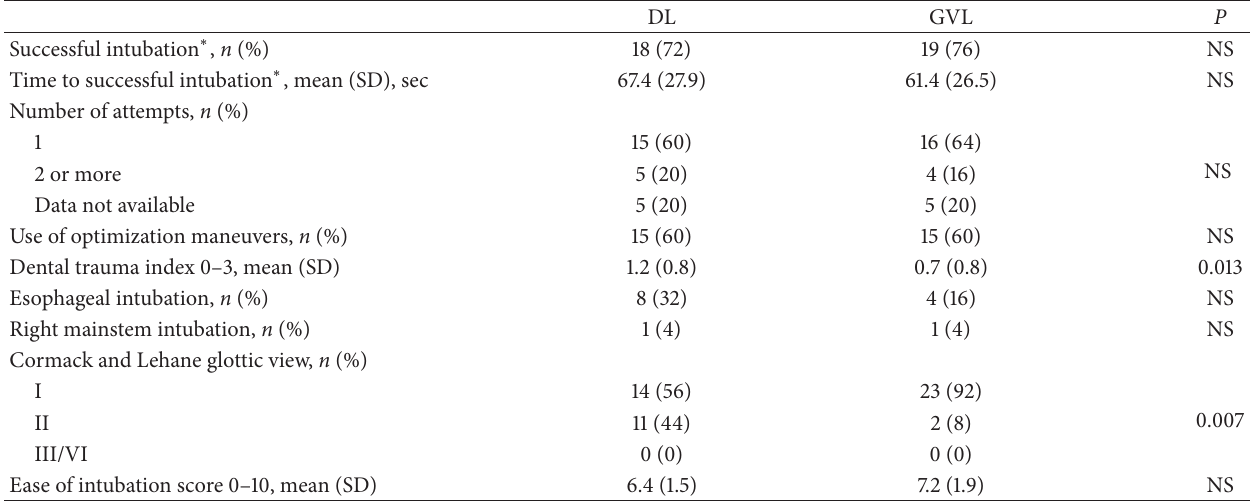
Table 2: Results for the normal airway scenario ( 𝑁 = 25 ).